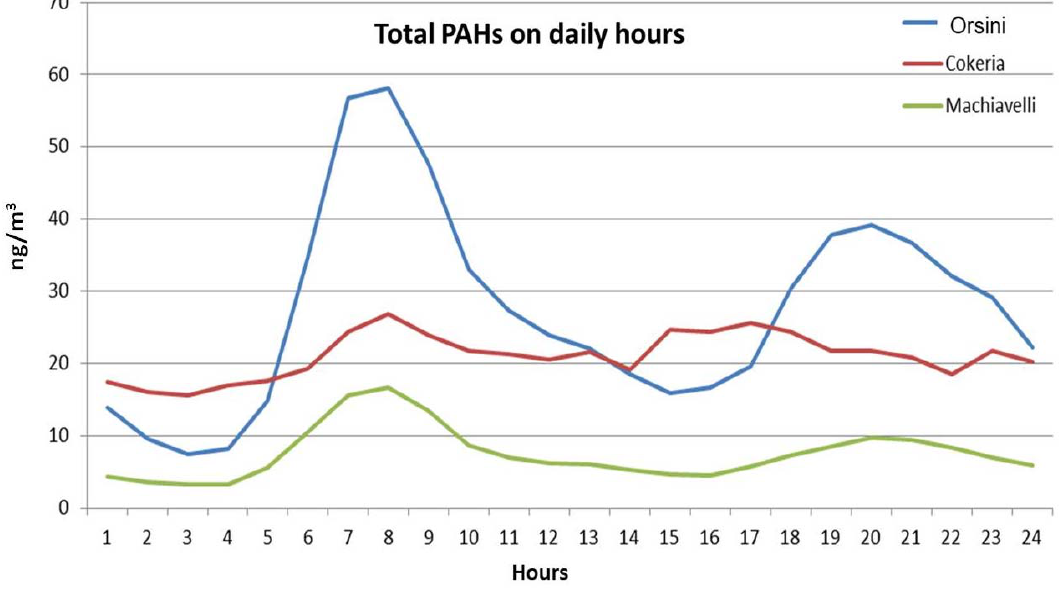
Figure 4. Average concentration of total p-PAHs for each hour of the day at the Orsini, Cokeria and Machiavelli sites. Data collected from 1 August 2013 to 31 July 2014.